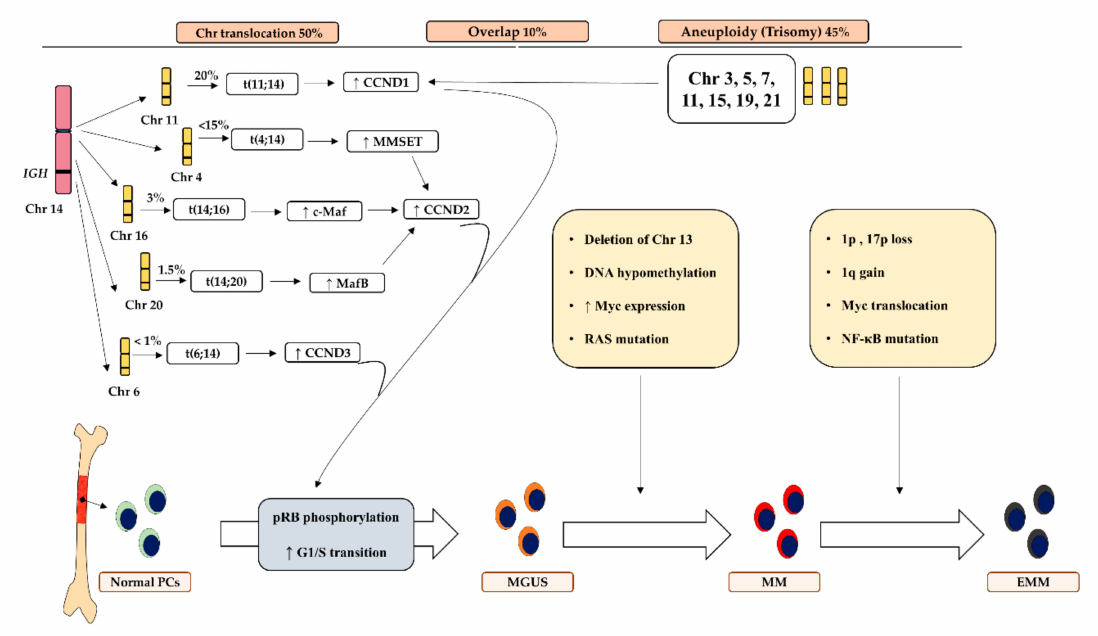
Figure 1. Molecular pathogenesis and underlying cytogenic alterations associated with MM development. Chromosomal translocations and aneuploidy disrupt cyclin D genes that in turn enhance G1/S transition of the cell cycle to induce abnormal cellular proliferation in plasma cells to develop MGUS. Other genetic mutations were found to be associated with the transformation of the disease towards MM and EMM. IGH; Immunoglobulin H, Chr: chromosome, PCs: plasma cells; MGUS: monoclonal gammopathy of undetermined significance, SMM: smoldering multiple myeloma, EMM: extramedullary multiple myeloma, CCDN: cyclin D, MMSET: multiple myeloma SET domain, NF- κ B: nuclear factor kappa-light-chain- enhancer of activated B cells, BM: bone